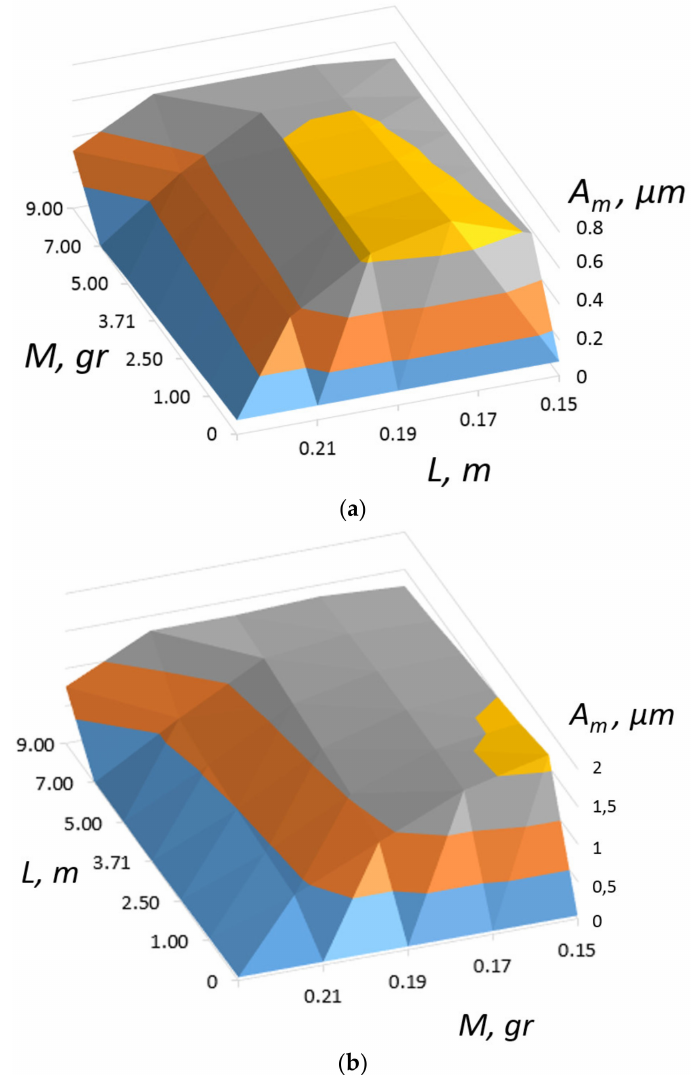
Figure 6. Dependence of 1 ( a ) and 2 ( b ) natural frequencies of PEG on the magnitude and location of proof mass.